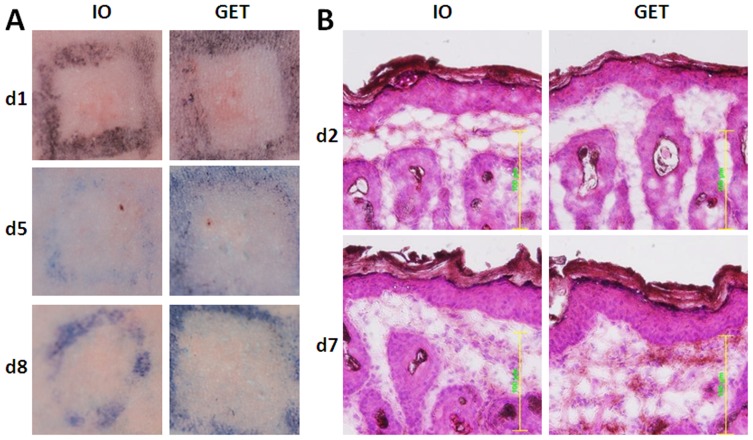
Gross observation and histology of HLGP skin after i.d. DNA injection and non-invasive GET.
A, Skin observation after delivery. Pictures were taken at post-delivery day 1, day 5 and day 8. One representative picture of 4 to 6 sites was shown here. Delivery group, IO: 50 µL DNA without pulse delivery; GET: 50 µL DNA with pulse delivery. B, H&E stained skin samples. One representative of 3 treated sites was presented here for post-delivery day 2 or day 7 (magnification  = 200, scale bar = 100 µm).